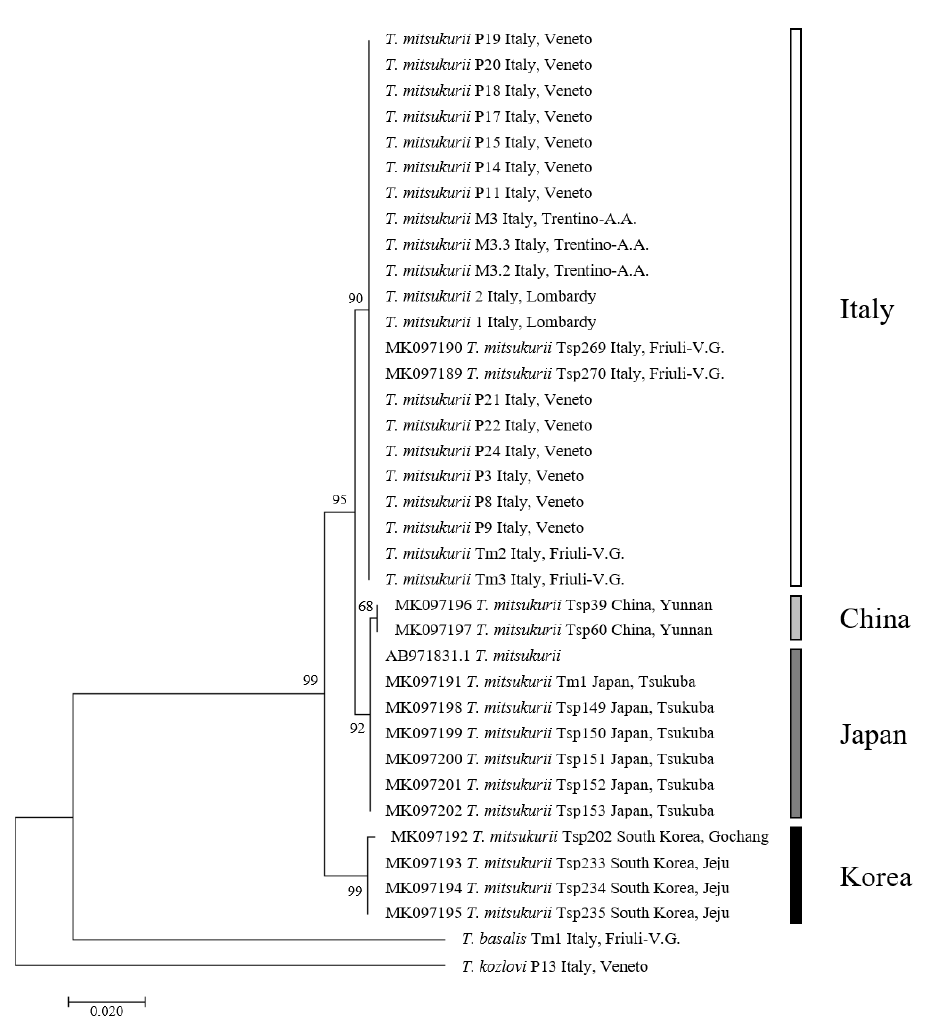
Figure 3. Maximum likelihood (ML) tree based on COI sequences of Trissolcus mitsukurii . Numbers on the nodes refer to ML bootstrap values.